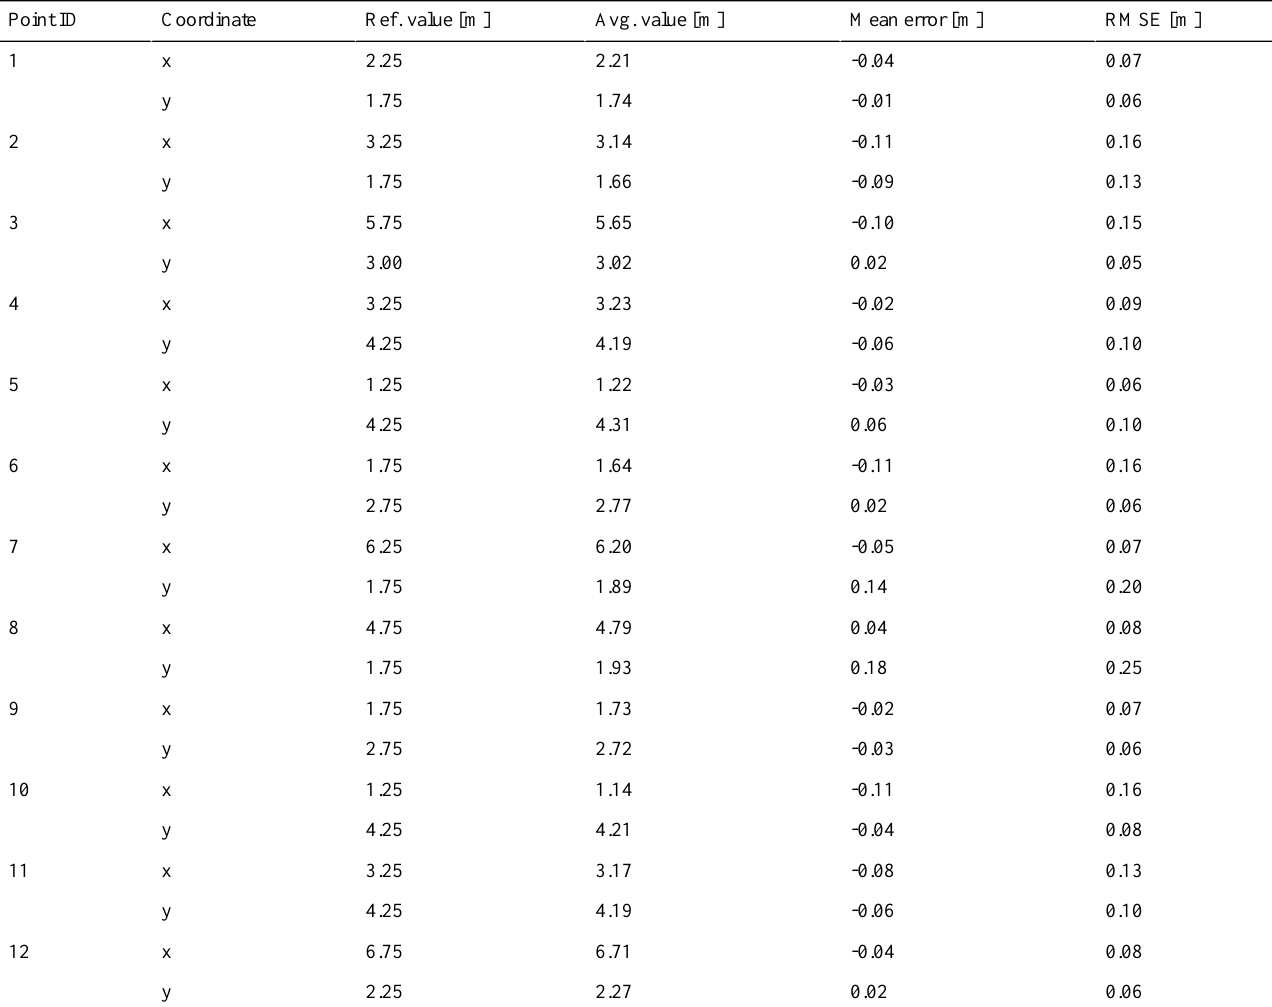
Table 1. Statistical results for position measurements of reference points.